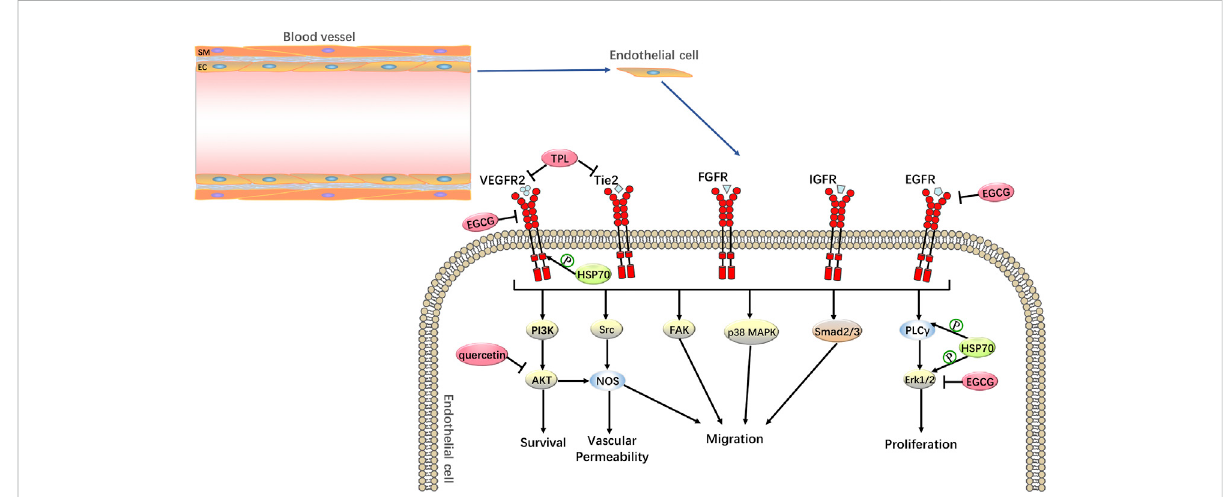
FIGURE 5 Anti-tumor Angiogenesis by HSP70 Inhibitors. HSP70 inhibitors can increase the radiosensitivity of tumor cells through anti-tumor angiogenesis. For example, in pancreatic cancer, TPL inhibits tumor angiogenesis by inhibiting Tie2 and VEGFR-2; in acute myeloid leukemia and breast cancer, quercetin targets theVEGFR-2-mediated angiogenic pathway and inhibits theexpression of the downstream regulator AKT; in breast cancer, EGCG is anti-tumor angiogenic by inhibiting the expression of VEGF and suppressing the phosphorylation levels of EGFR and